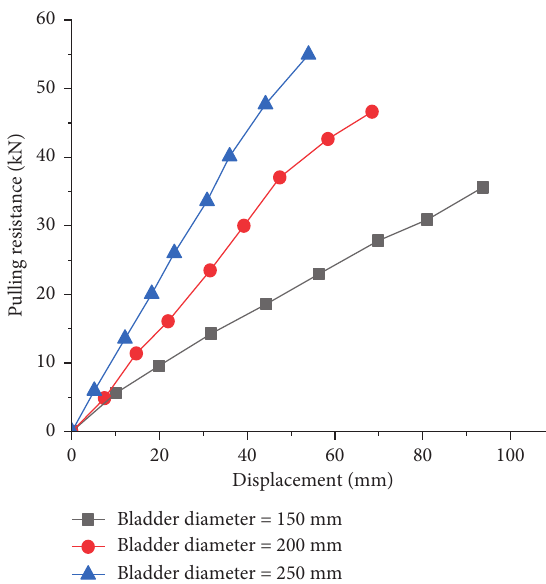
Figure 10: The pulling force vs. displacement relationship under different bladder diameter conditions.